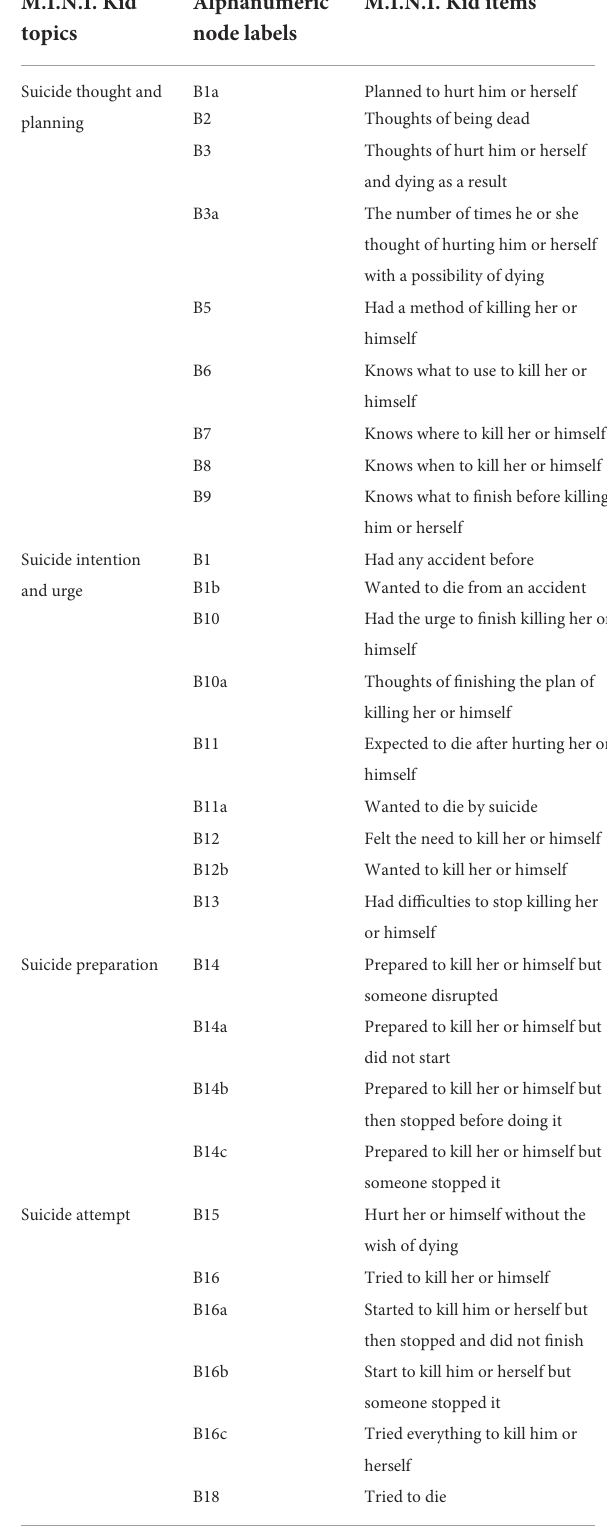
TABLE 1 M.I.N.I Kid items and the corresponding alphanumeric node labels in Figures